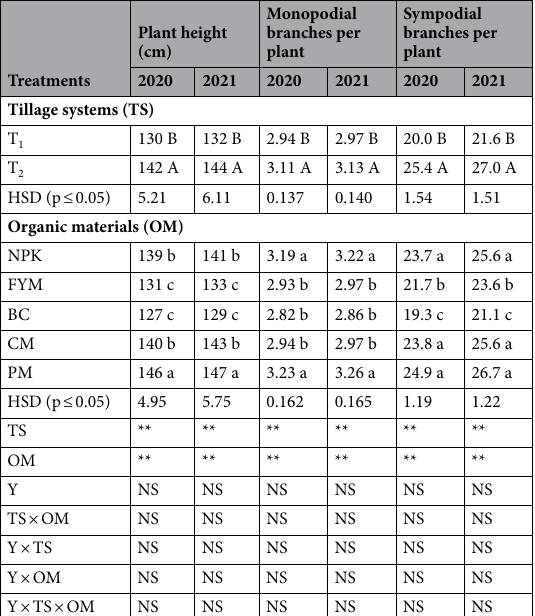
Table 2. Effect of different tillage systems and organic materials on the morphological attributes of cotton crop. Values sharing the same alphabet letters did not differ markedly at p ≤ 0.05 for a particular trait. NS non- significant p ≤ 0.05, T 1 conventional tillage, T 2 conservation tillage, FYM farmyard manure, BC biochar, CM compost, PM poultry manure. *Significant at p ≤ 0.05. **Significant at p ≤ 0.01.